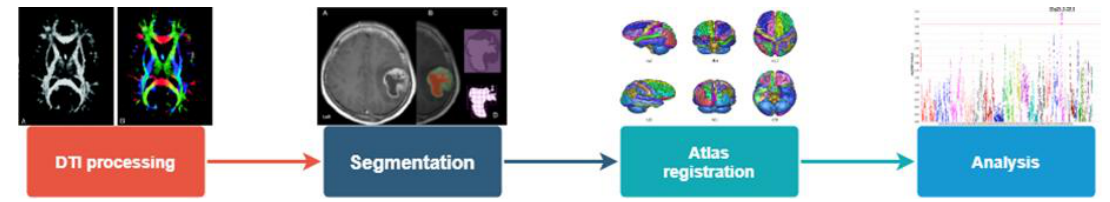
Figure 1. Flow chart of image analysis and data processing.